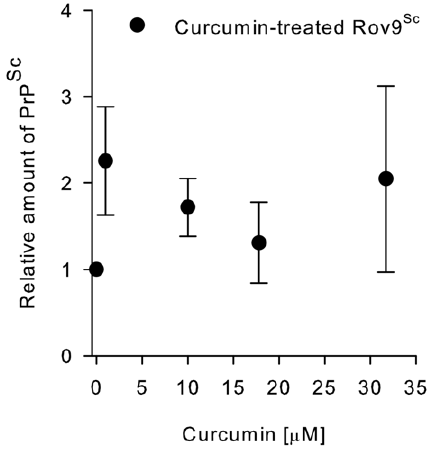
Figure 6. Curcumin does not inhibit PrP Sc accumulation, even at cytotoxic concentrations. Rov9 Sc cells were exposed to a dilution series of curcumin for four days, and then an aliquot of cells was lysed for PrP Sc ELISA. A standard curve was used to transform the corrected optical densities into relative concentration of PrP Sc . Data points represent the means 6 one standard deviation of four independent experiments. Rov Sc/UnTx were set to 1, and all other points were normalized to this